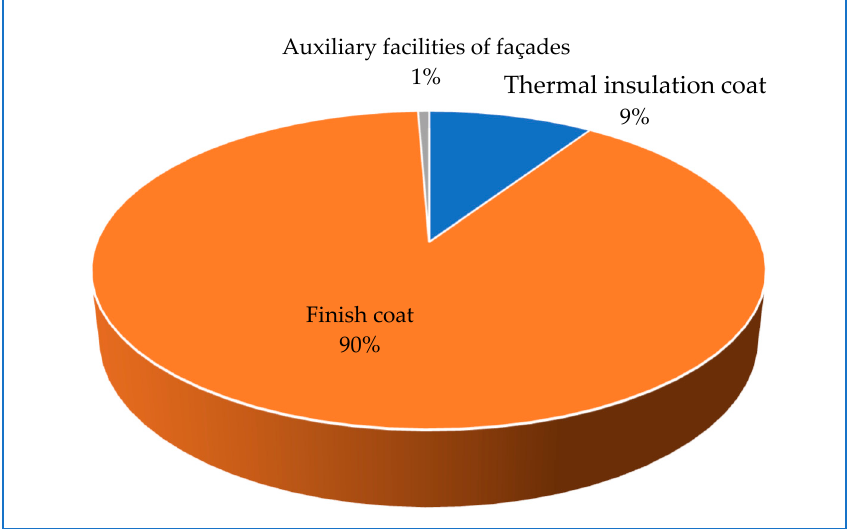
Figure 8. Proportion of the types of façades appeared falling objects.